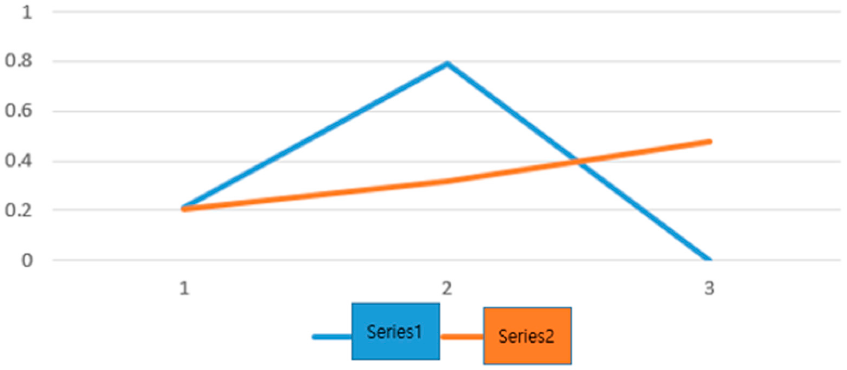
Figure 26. Comparison between the appearance frequency of “mosquito” and maximum power (“Living Culture” section of Naver news,